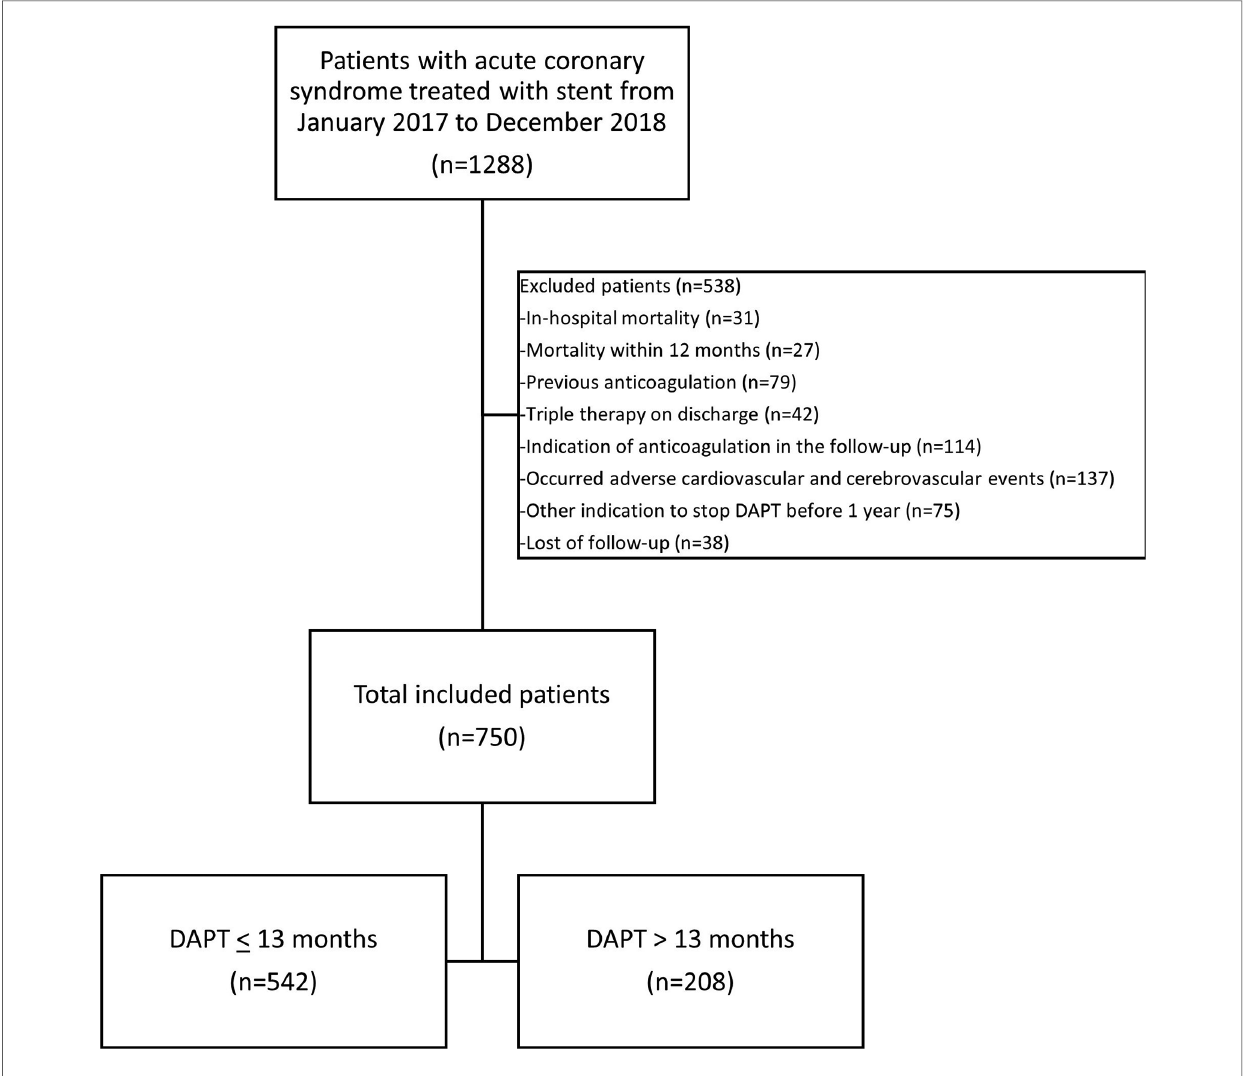
FIGURE 1 Flowchart of the